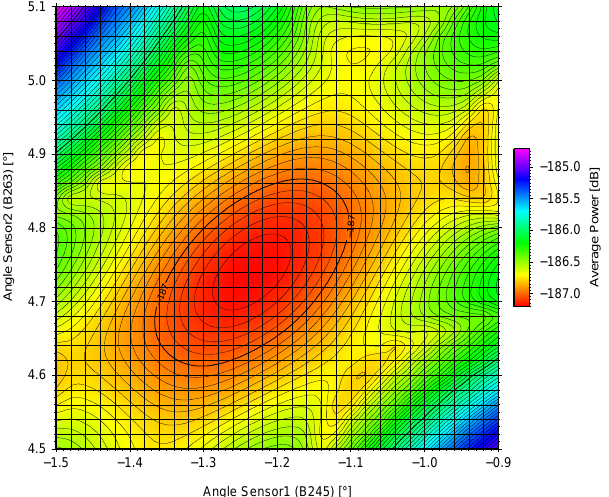
Fig. 3. Mean self-noise in the 0.02–0.7Hz frequency range from in- crementally rotating the N/S-components of sensors B245 and B263 in order to align them with B267.